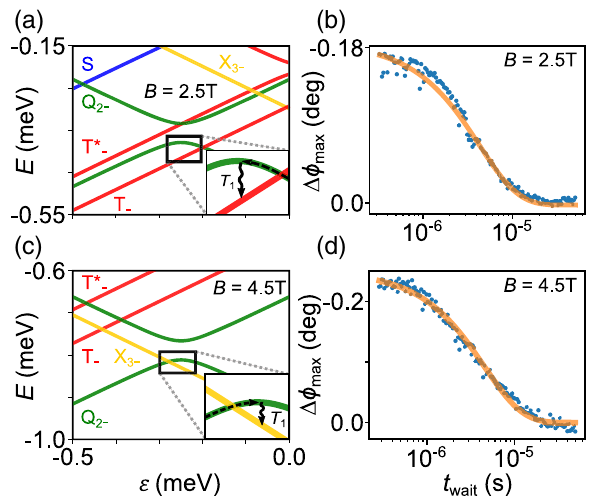
FIG. 3. Quintet relaxation. (a,c) Energy levels of the double quantum dots at magnetic fields of B ¼ 2 . 5 T and B ¼ 4 . 5 T simulated based on parameters extracted from magnetospectro- scopy measurements presented in Fig. 2. The insets highlight the pulsing into the quintet Q 2 − anticrossing and the subsequent relaxation into the triplet T − and septet X 3 − ground states, respectively. (b,d) Decay of the maximum ICT phase response Δ ϕ as a function of wait time t at the Q 2 − anticrossing. max wait By fitting to a single exponential decay (orange line), we observe quintet relaxation times of T Q → T 1 ¼ 4 . 26 (cid:3) 0 . 11 μ s and T Q → X 1 ¼ 4 . 59 (cid:3) 0 . 11 μ